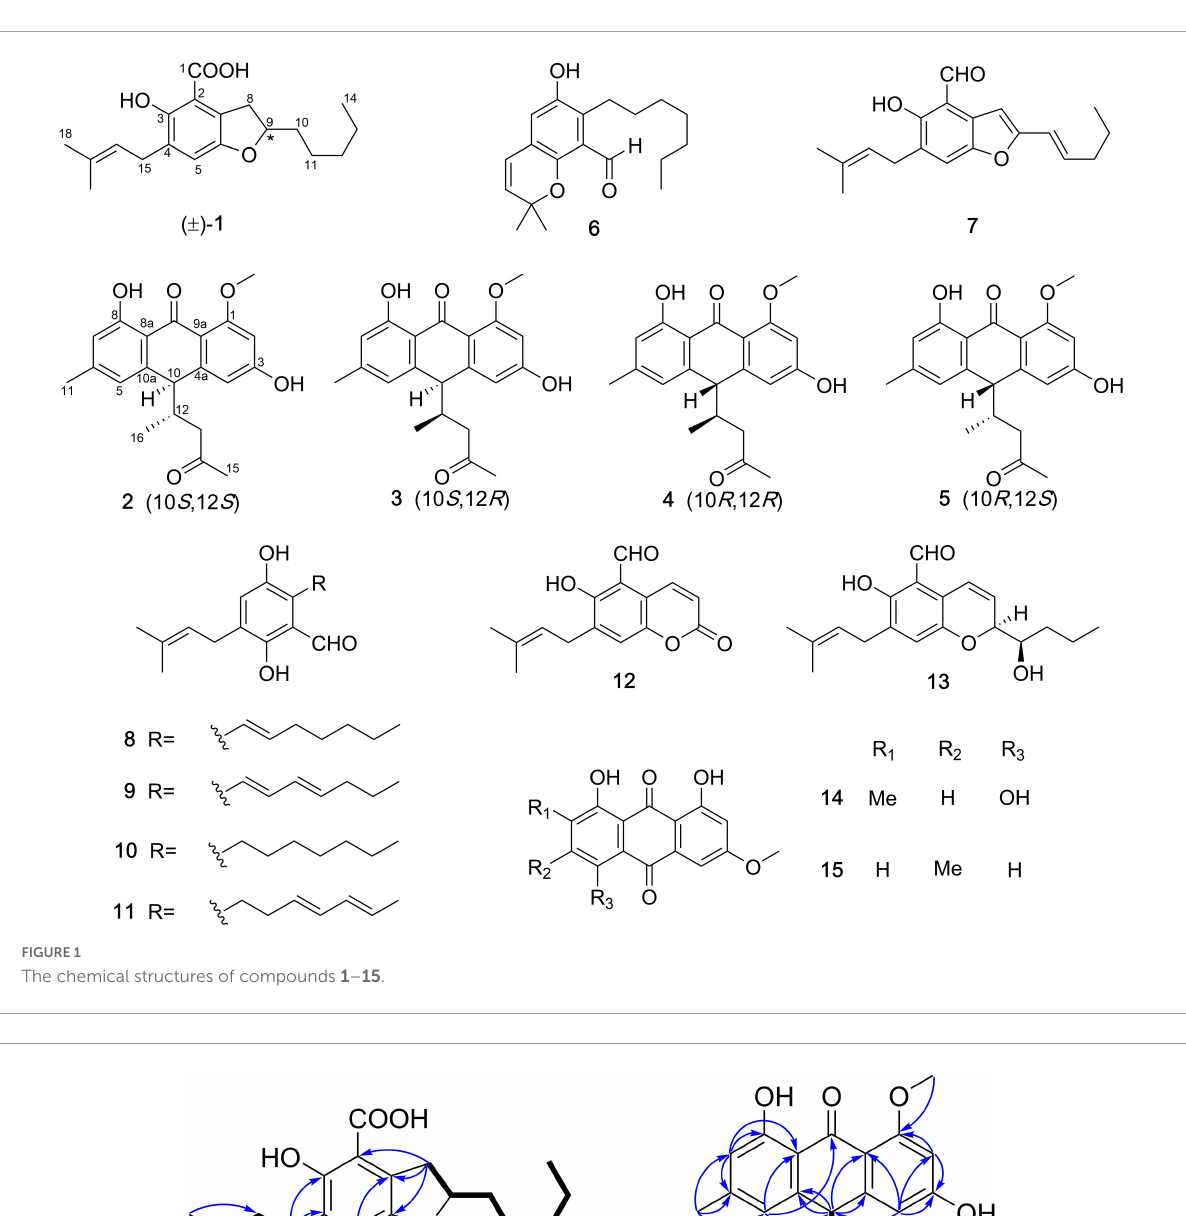
FIGURE2 Key HMBC and 1 H- 1 H COSY correlations of 1 and 2 .